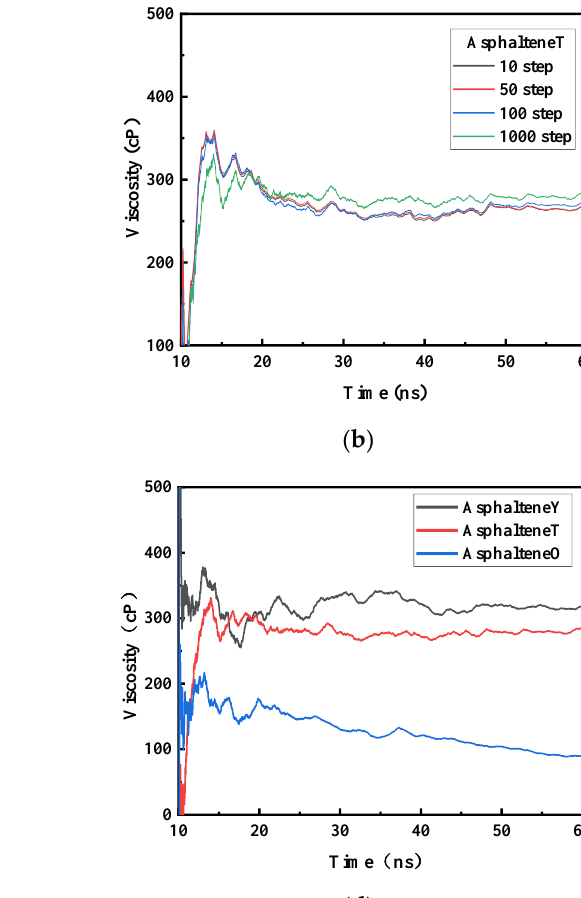
( c ) Figure 5. The aggregation behavior of asphaltene molecular dimers [18]. ( a ) Face – face geometry, ( b ) T-shaped or edge-on geometry, and ( c ) offset π -stacked geometry. In this study, the three asphaltene molecules are classified as AsphalteneO, As- phalteneT, and AsphalteneY according to their structure. The three asphaltene molecules after NEMD simulation are visualized by VMD 1.9.4 software to observe the specific ag- gregation patterns of asphaltene molecules with different structures, as shown in Figure 6. ( a )